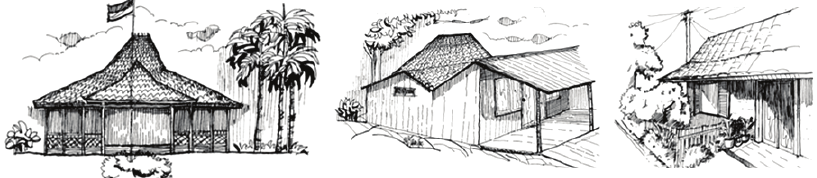
Figure 2. From left to the right: Joglo Pendopo , and the Joglo Limasan houses of Sunan’s descendants (source: Survey, 2017)